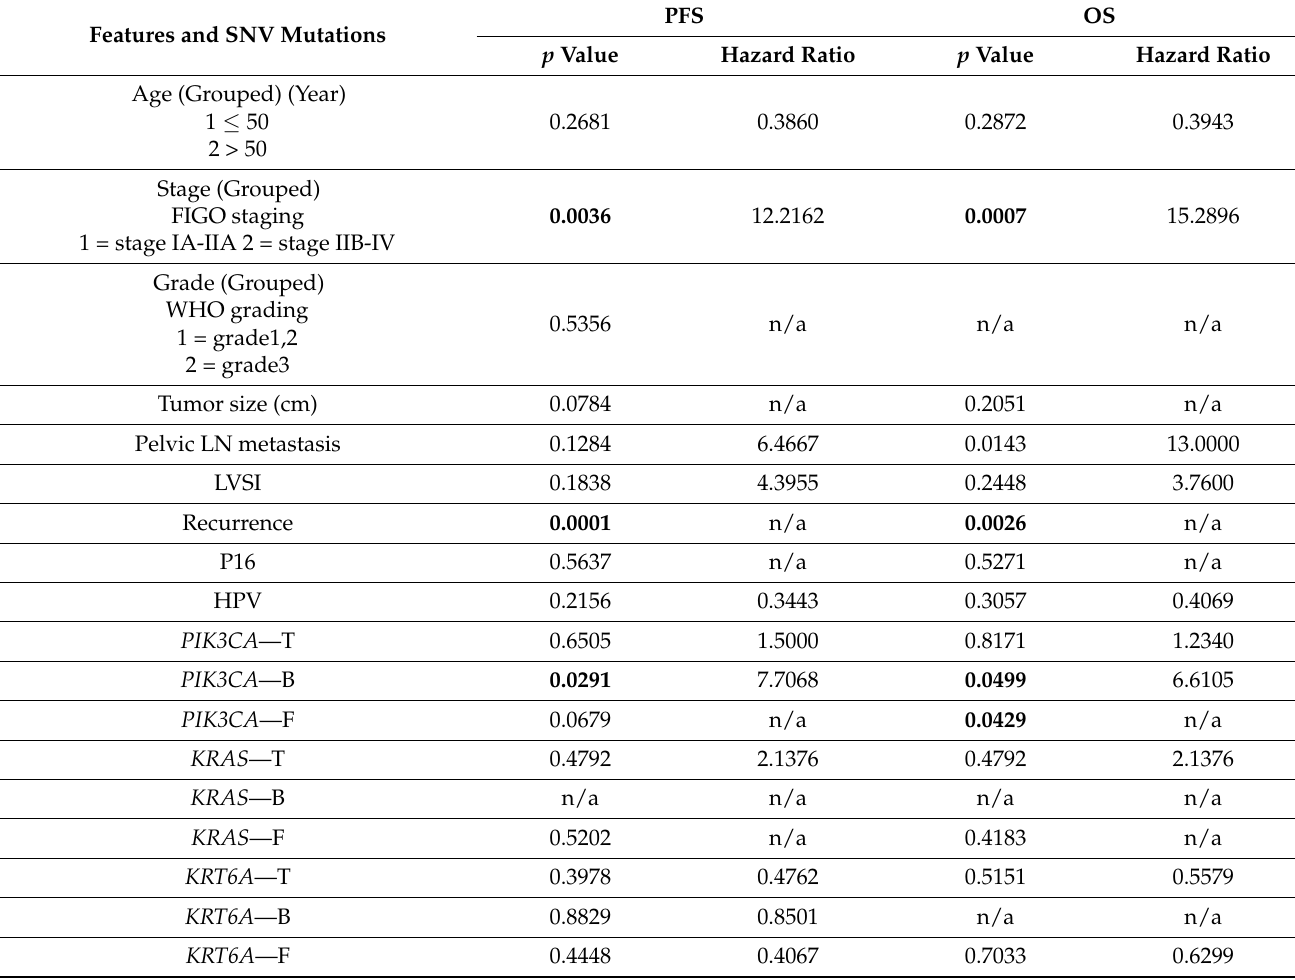
Figure 1. Kaplan–Meier analysis ( A ) Progression-free survival correlated to PIK3CA in circulating DNA collected before treatment in cervical adenocarcinoma ( p = 0.0291) (hazard ratio = 7.7068). ( B ) Overall survival correlated to PIK3CA in circulating DNA collected before treatment in cervical adenocarcinoma ( p = 0.0499) (hazard ratio = 6.6105). Table 2. Survival analysis related to clinicopathological features and gene mutations in cervical adenocarcinoma using Kaplan–Meier survival curve and log-rank